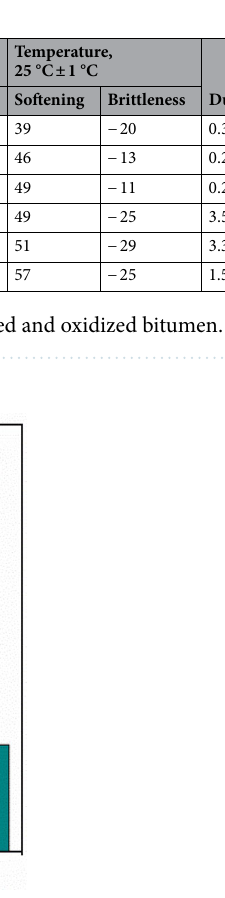
Figure 1. The schematic of composition fraction of feedstocks and of the non-oxidized bitumen.